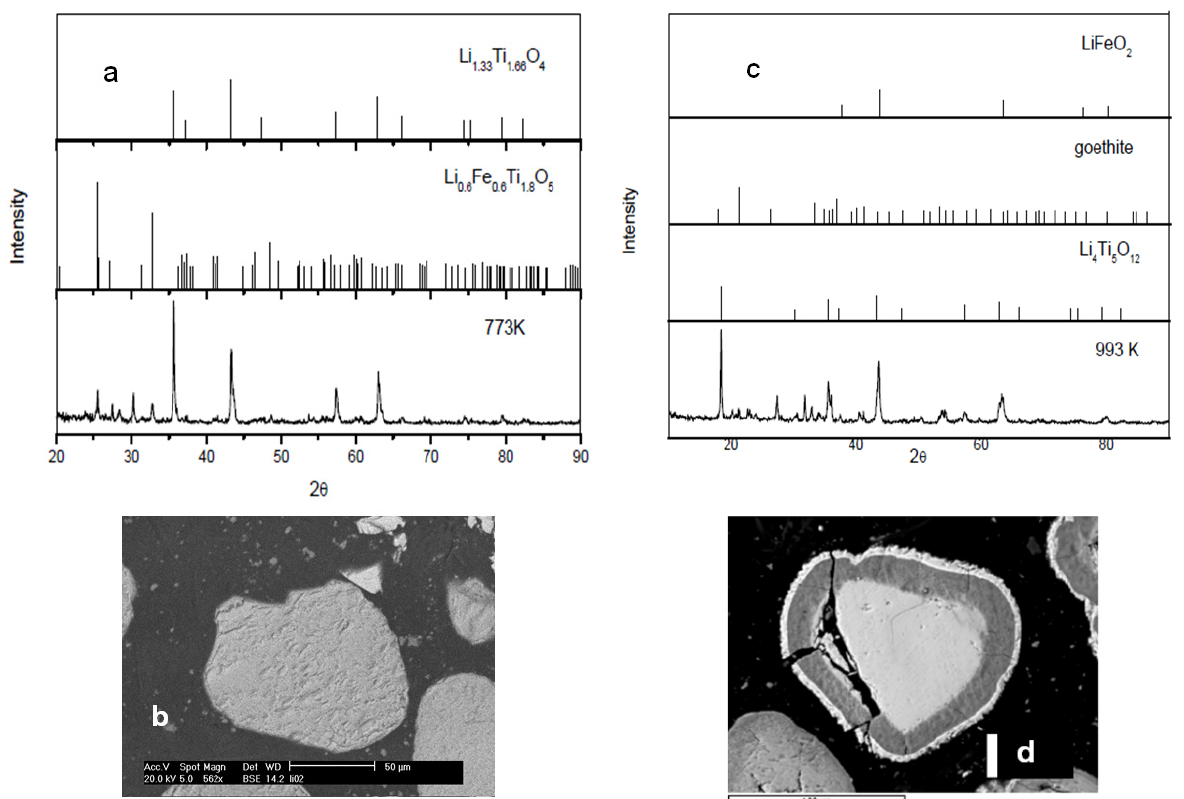
Figure 7: (a) XRPD pattern of ilmenite roasted with LiOH; (b) Backscattered image of ilmenite roasted with LiOH at 500 o C; (c) XRPD pattern of ilmenite roasted with Li